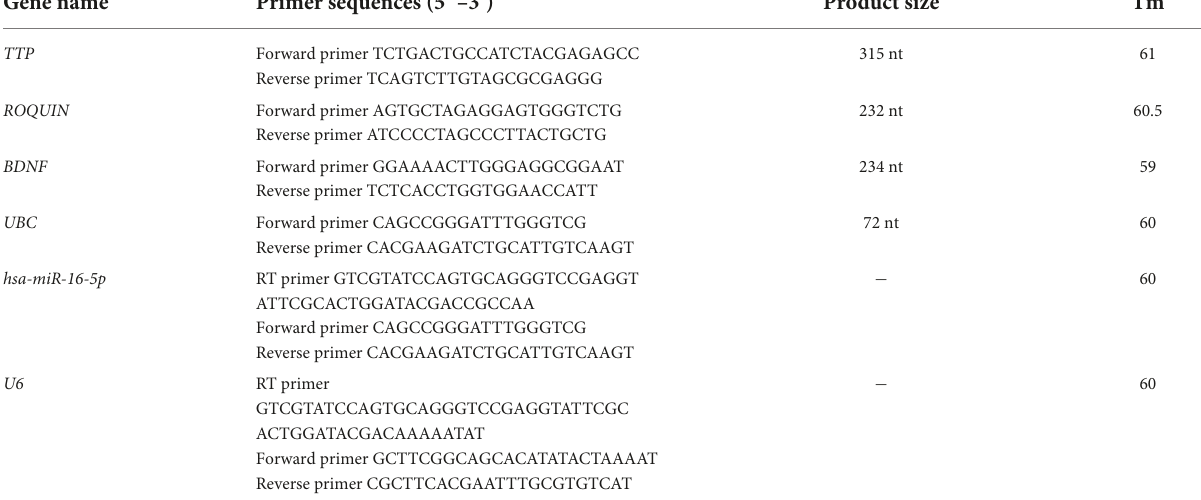
TABLE 1 List of primers used in this study.